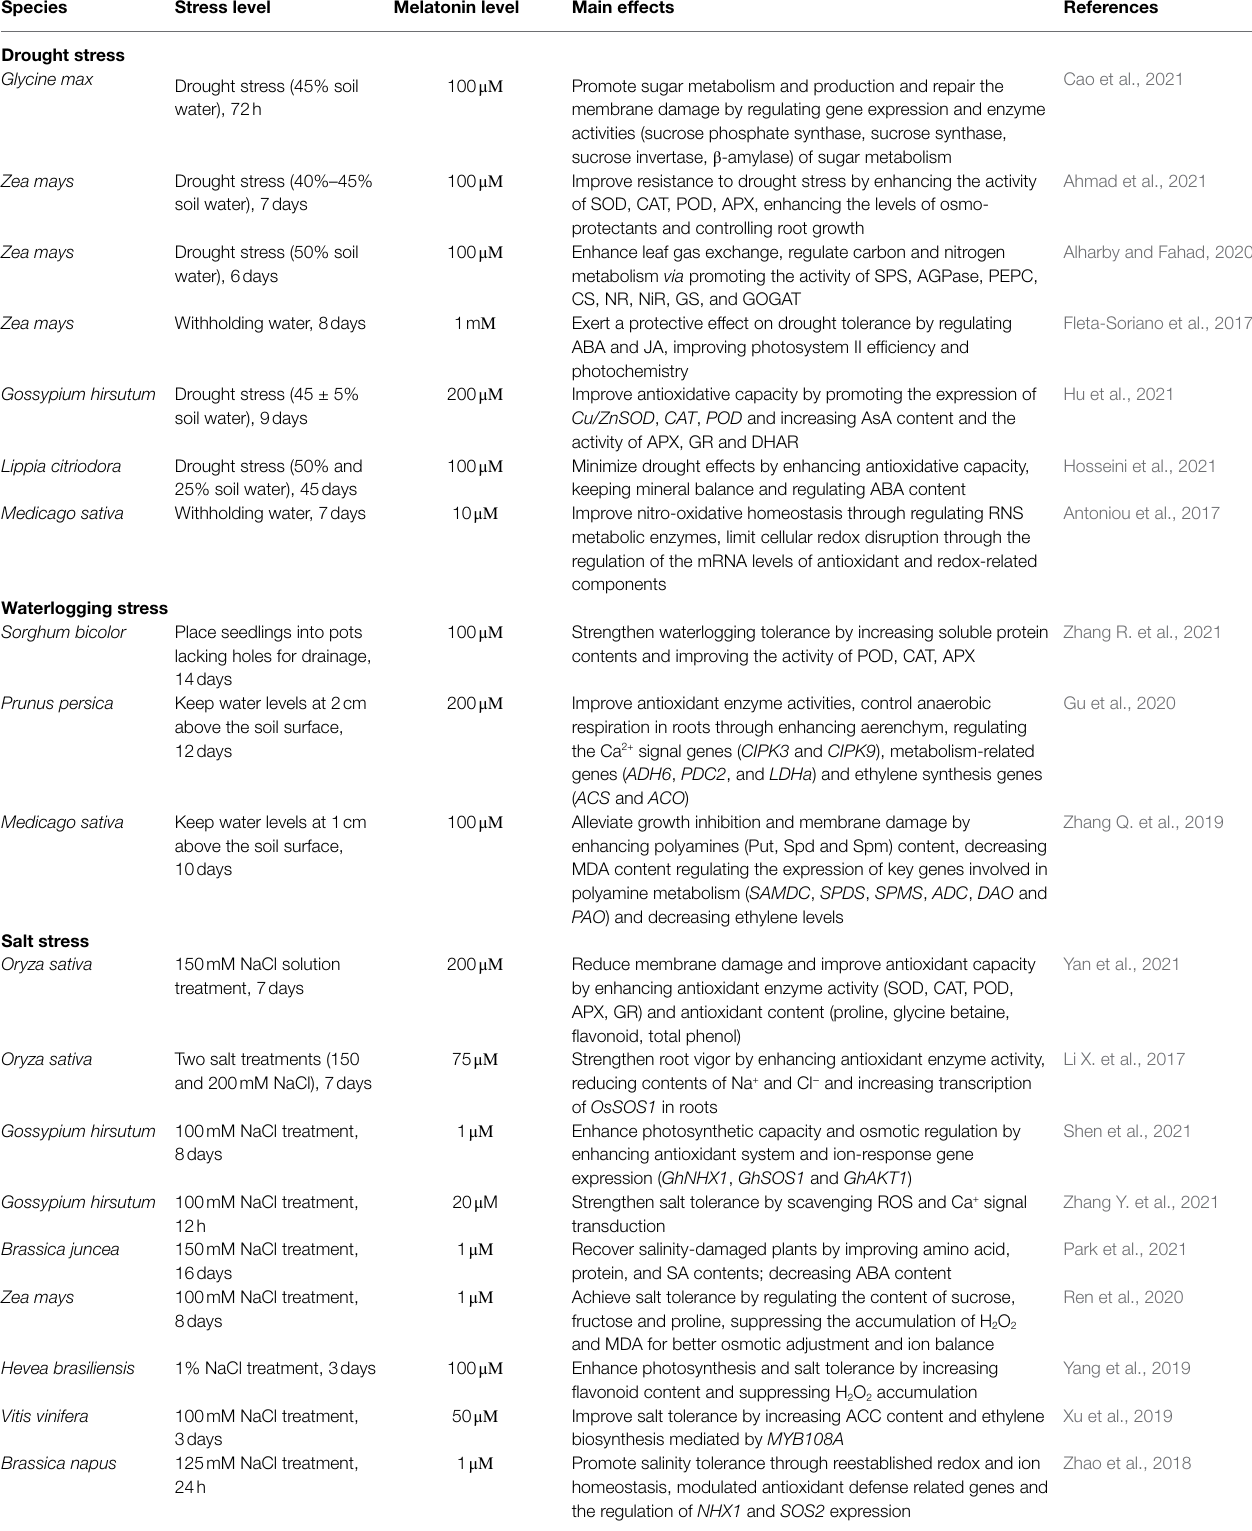
TABLE 1 | Exogenous melatonin application to plants under abiotic